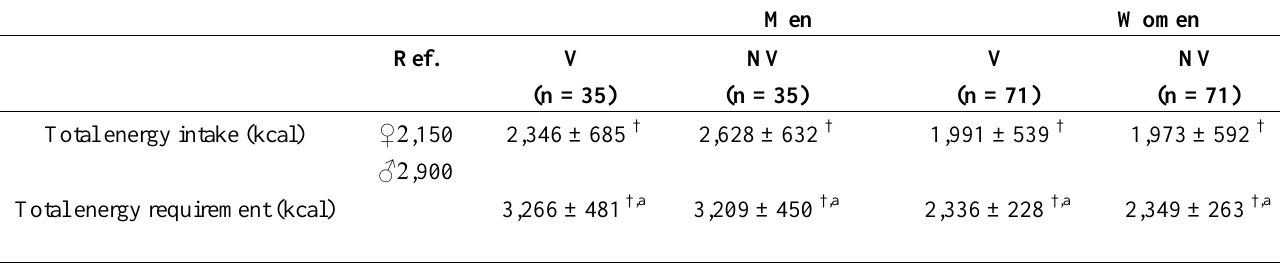
Table 4. Total energy and macronutrient intake (energy percentage, E%) in vegetarian (V) and omnivorous (NV)